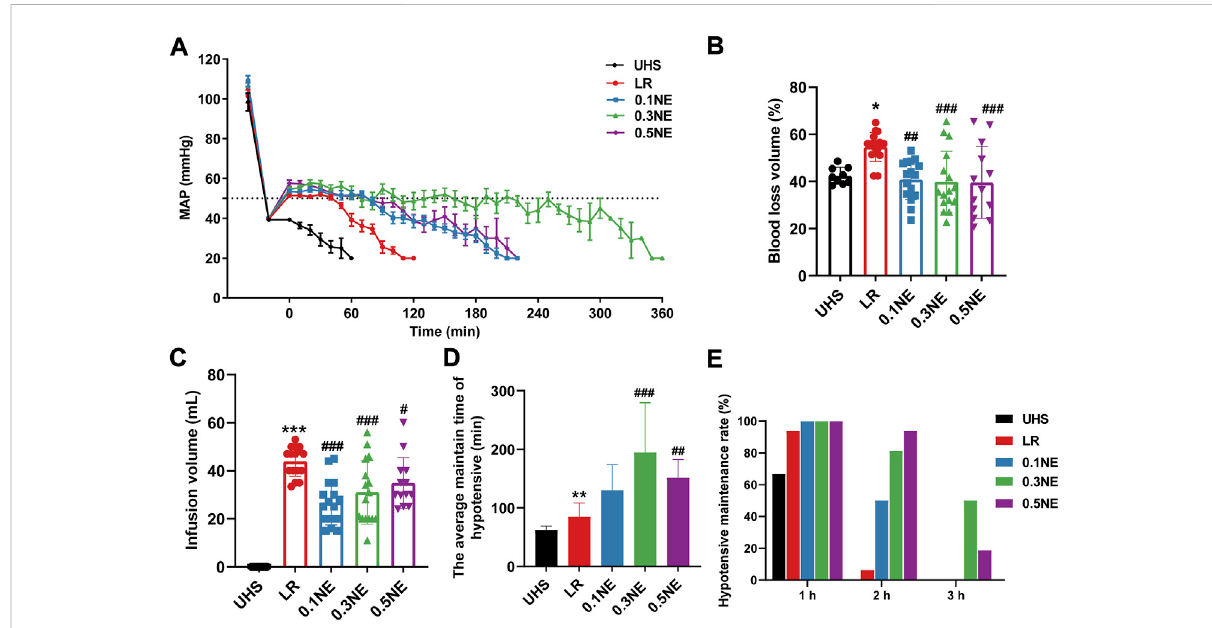
FIGURE 2 NE prolonged the golden treatment time for UHS. (A) Mean arterial pressure (MAP). (B,C) Blood loss and infusion volume in permissive hypotensive maintenance period (Phase II). (D) The hypotensive maintenance time of NE or LR. (E) The hypotensive maintenance rate of rats